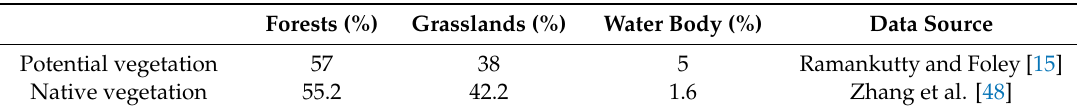
Table 1. Comparison between potential vegetation and native vegetation in northeastern